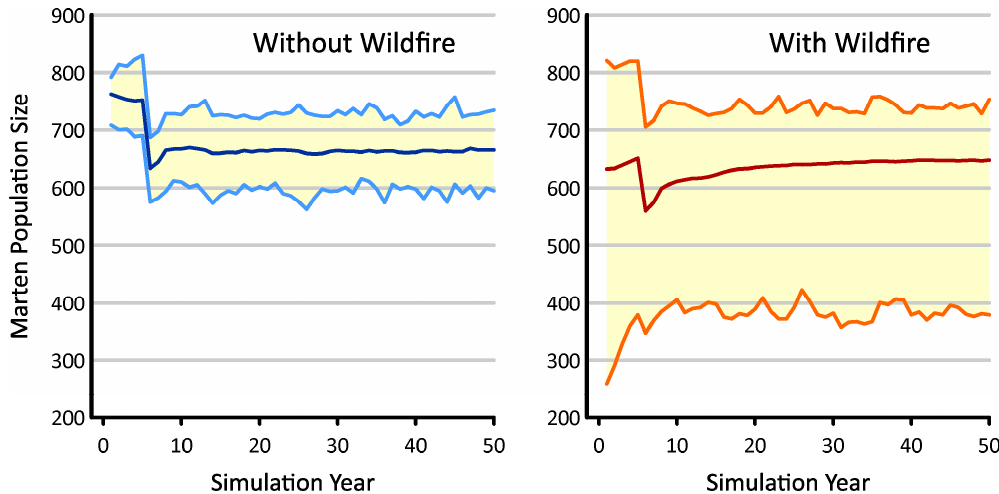
Figure 9. Estimates of population size from marten life history simulator, without ( left , 100 repli- cates) and including ( right , 1000 replicates) impacts from wildfire. The dark blue and red lines at the plot centers indicate mean population size, while the pairs of light blue and orange lines bracket the range of observed values.